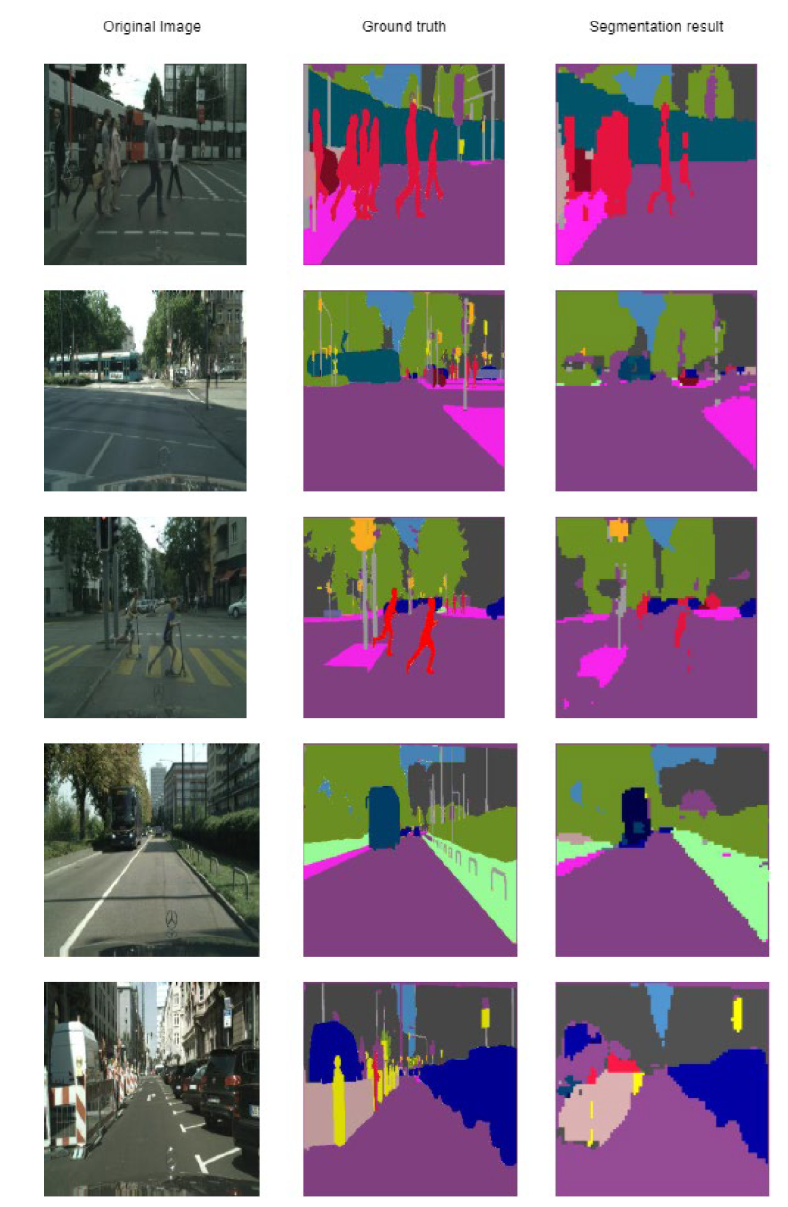
Figure 6. Segmentation result on classes on the Cityscapes dataset